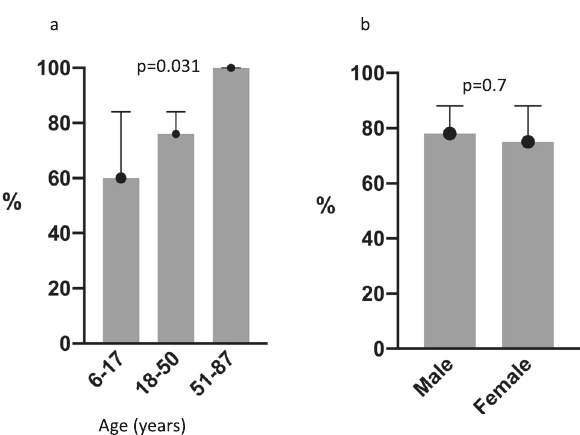
Fig. 4 Proportion of individuals responding to atleast one KSHV ORF.